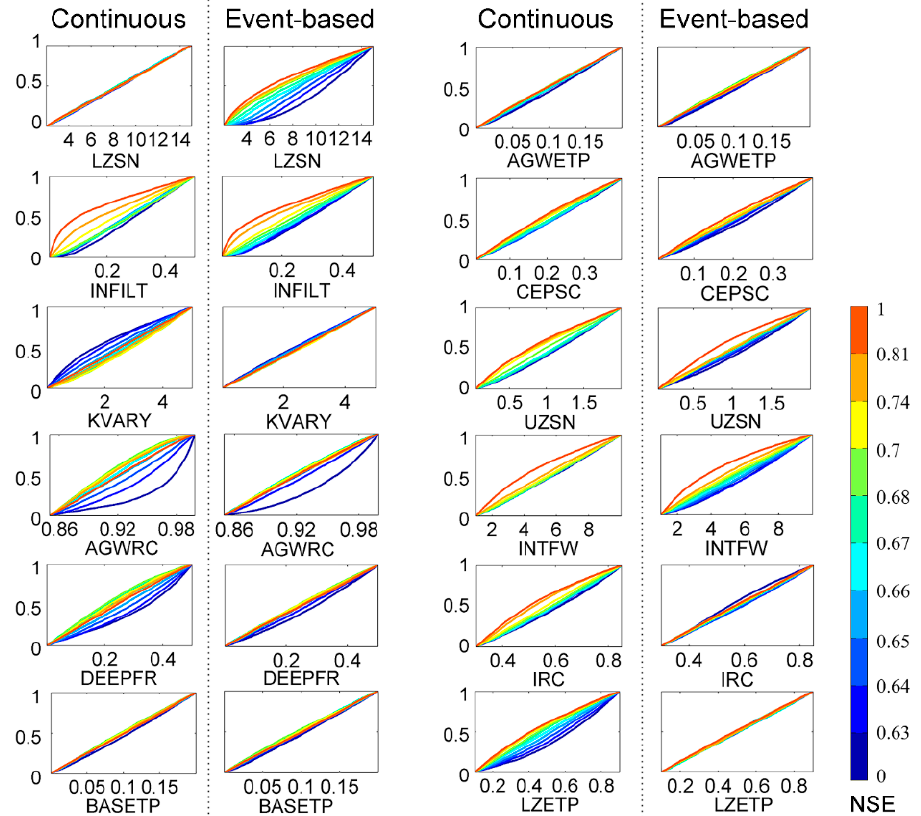
Figure 9. Comparison of parameter sensitivity between the continuous and event-based modeling Cumulative normalized Nash–Sutcliffe efficiency were plotted against parameter values. Parameter populations from best to worst are ranked and divided into ten bins of equal size.